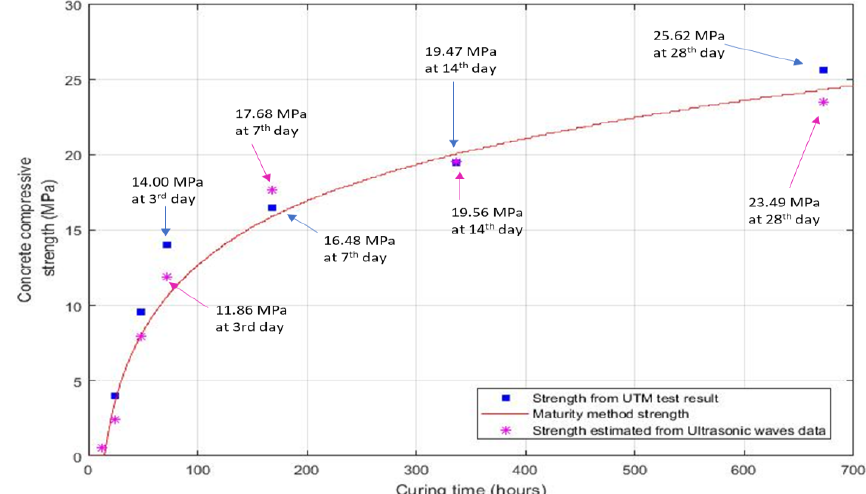
Figure 11. Concrete compressive strength measured by the maturity method, universal testing machine (UTM) test, and ultrasonic wave